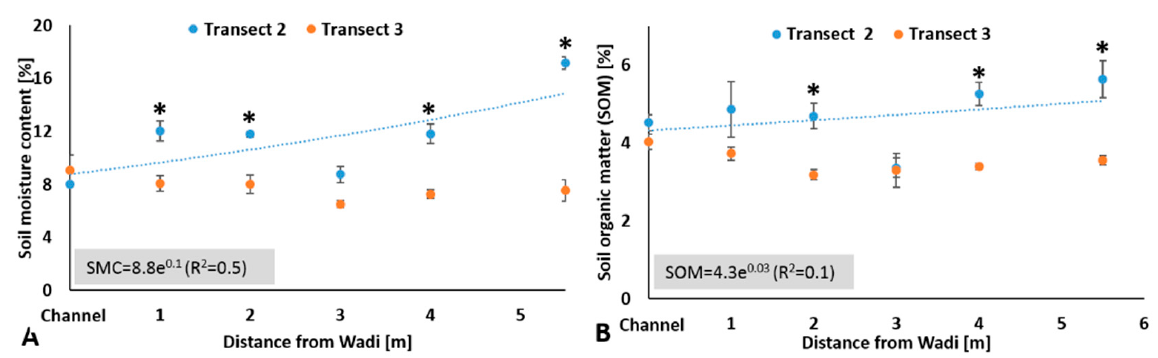
Figure 7. The soil organic matter and moisture content over the slopes of the inward and outward parts of the curved plot. ( A ) Soil moisture content, ( B ) soil organic matter; Transect 2—outward part, Transect 3—inward part. Lines on columns/graph: mean ± SE, Statistics: t-test (comparison of values located in the similar contour of transects), *—Significant.